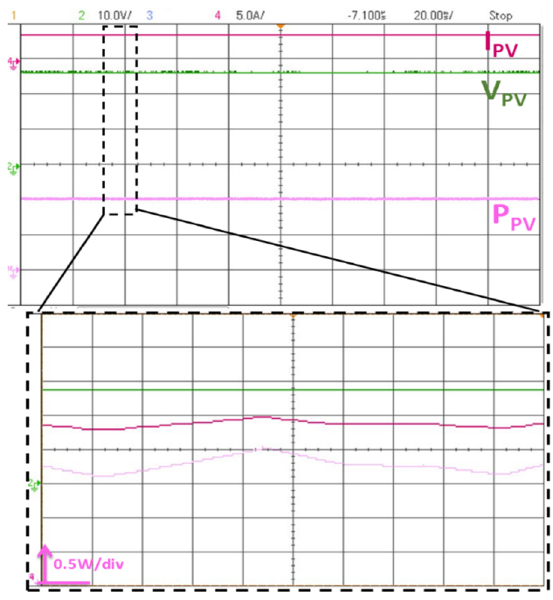
Figure 12. Steady state PV power oscillations for the proposed fixed-frequency predictive MPPT (Ch2 (green) is PV voltage, Ch4 (pink line) is the PV current), the PV extracted power (lavender line).